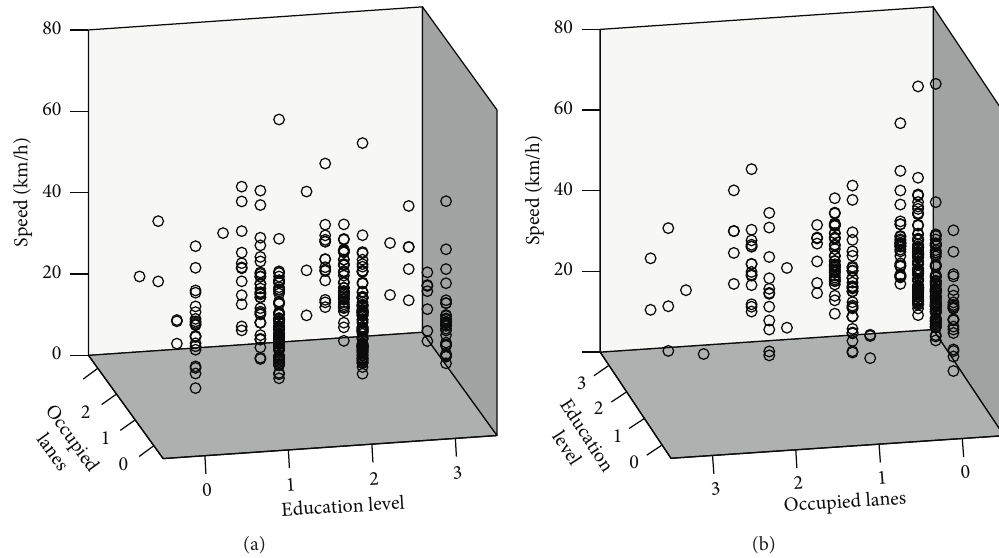
Figure 8: Relationship between the educational level, traveling speed, and illegal lane occupation